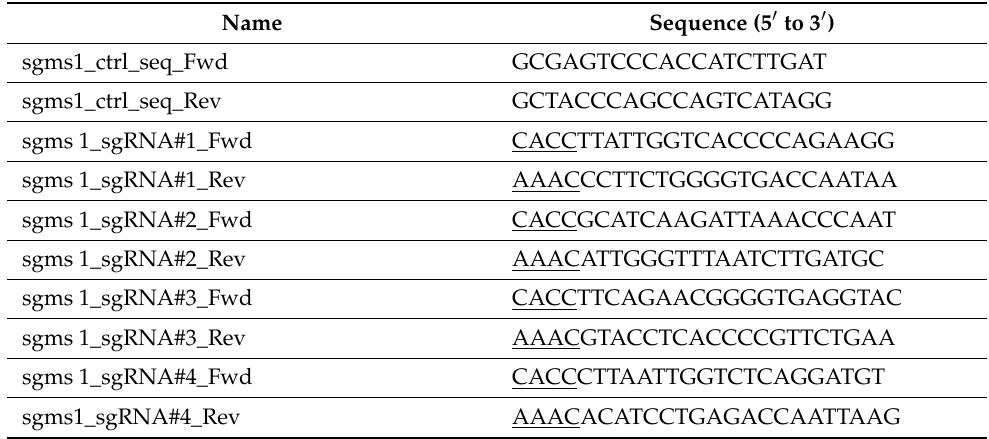
Table 3. Oligonucleotide sequences. Compatible 5 (cid:48) overhangs for restriction enzyme BbsI used for cloning are